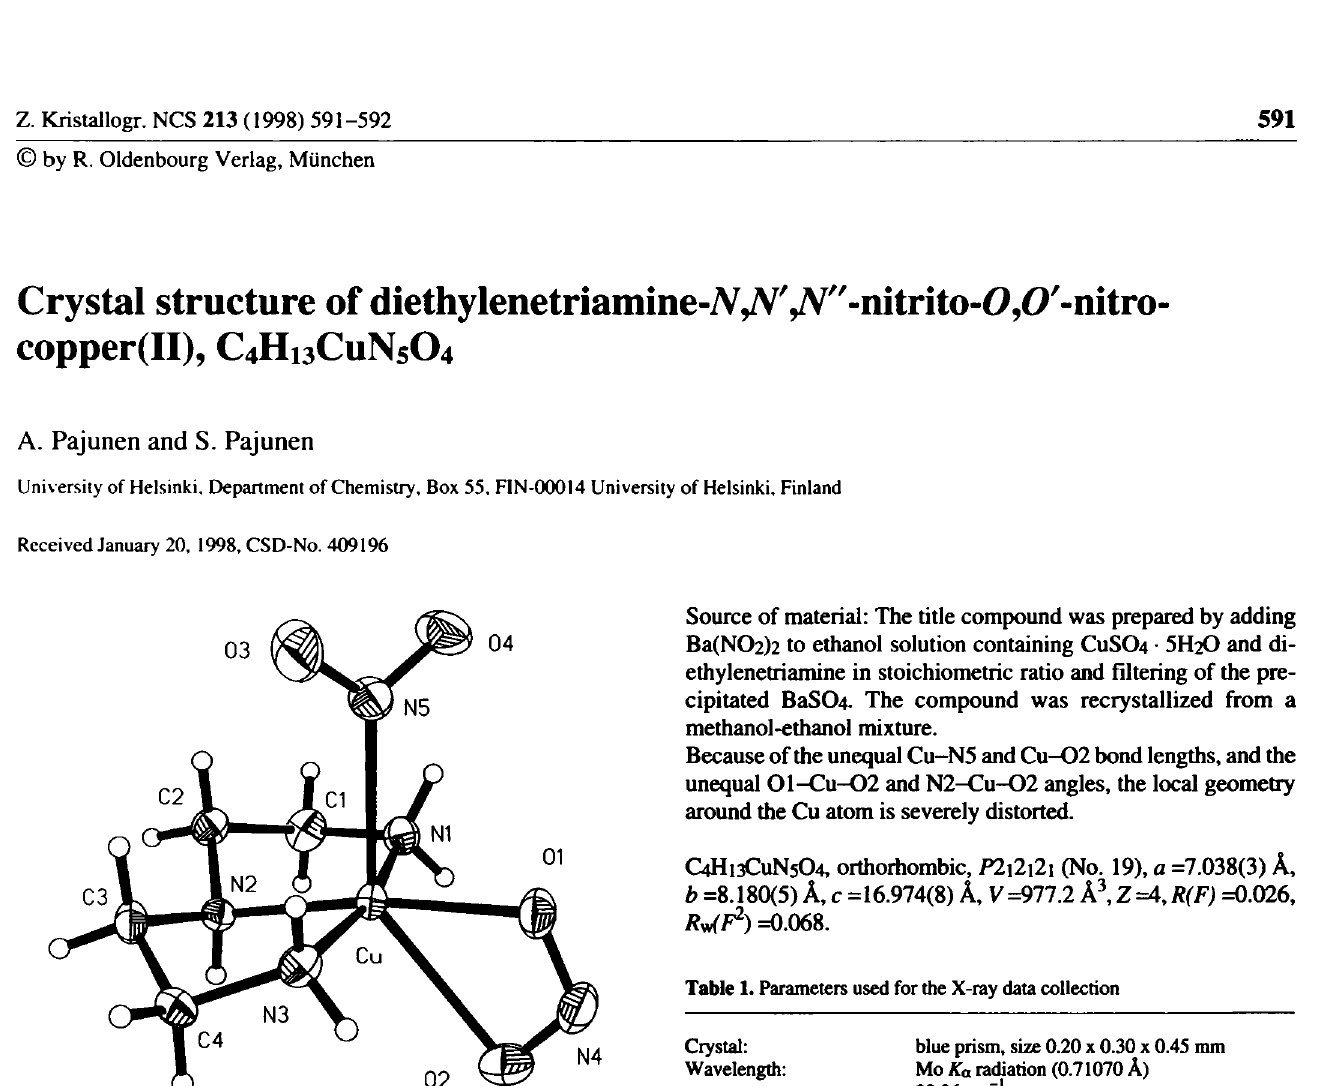
Fig. 1. Molecule plot.